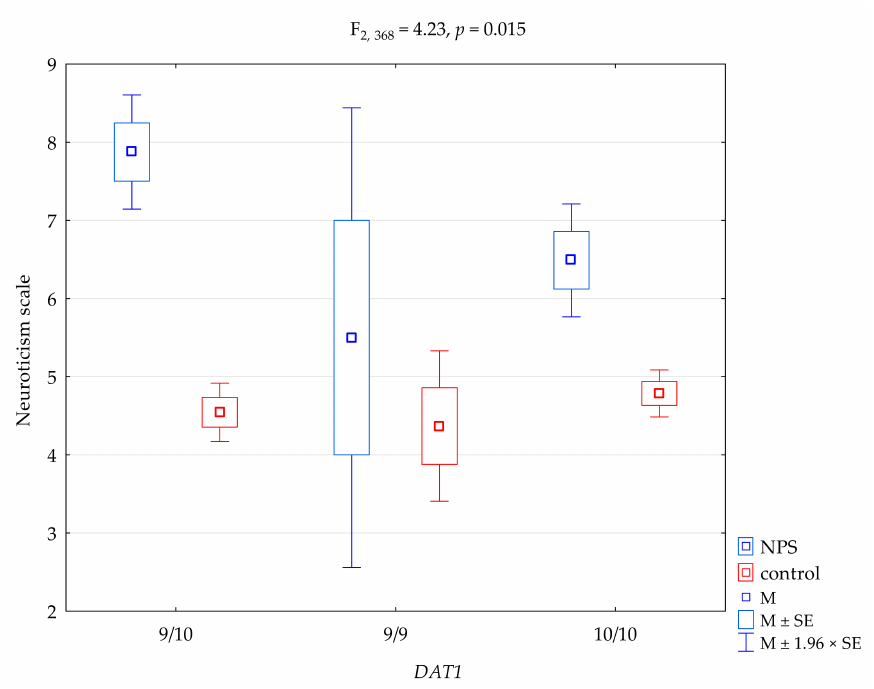
Figure 1. Interaction between users of ‘new psychoactive substances’ (NPS)/controls, DAT1 poly- morphisms, and the NEO-FFI neuroticism scale. M, mean; SE, standard error.